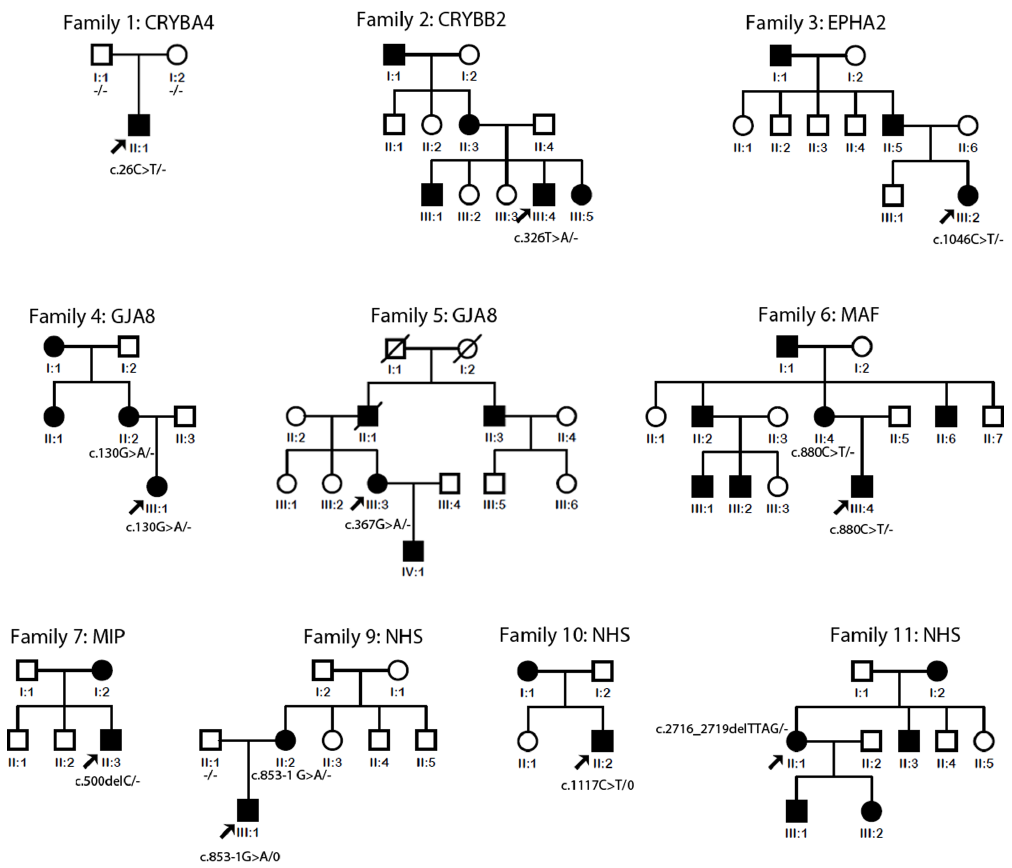
Figure 1. Pedigrees of the 9 available families with mutations. The family number and their causative gene were just noted above the pedigree. The mutations of available members were noted beside or below the members. The – indicated that the mutation was not present in the chromosome while the 0 indicated that males had only one X chromosome. Family 8 was recorded to have a history of congenital cataracts but the details of the pedigree are not available. The